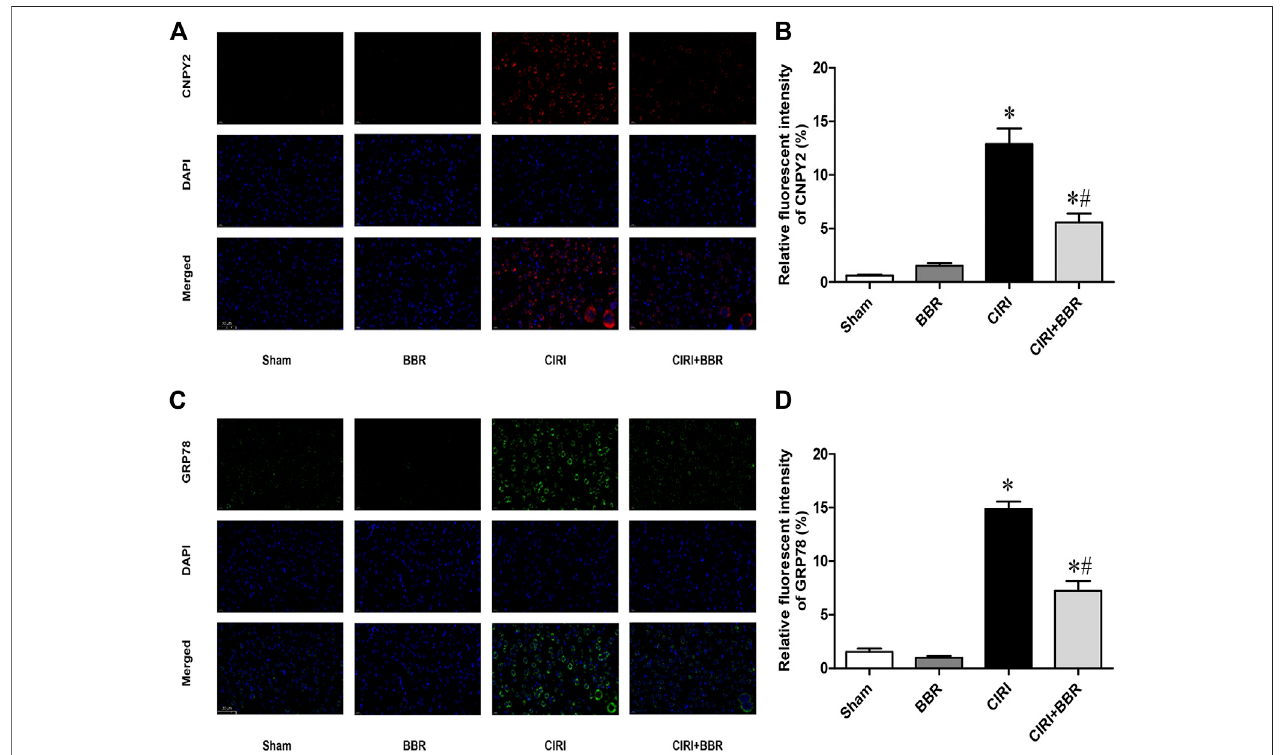
FIGURE 4 | BBR inhibits CNPY2-mediated ERS pathway. The expression of CNPY2 and GRP78 in ischemic brain tissue was analyzed by immuno fl uorescence staining to further evaluate the effect of BBR on the ERS pathway. (A) , The location of CNPY2 in the ischemic penumbra of each group. (B) , Ratio of fl uorescence intensityofCNPY2inischemicpenumbra. (C) ,ThelocationofCNPY2intheischemicpenumbraofeachgroup. (D) ,Ratioof fl uorescenceintensityofCNPY2inischemic penumbra. Original magni fi cation is 400 × , scale bars is 20 μ m n (cid:2) 6. Data are shown as the mean ± SEM. * p < 0.05 compared with the Sham group; # p < 0.05 compared with the CIRI